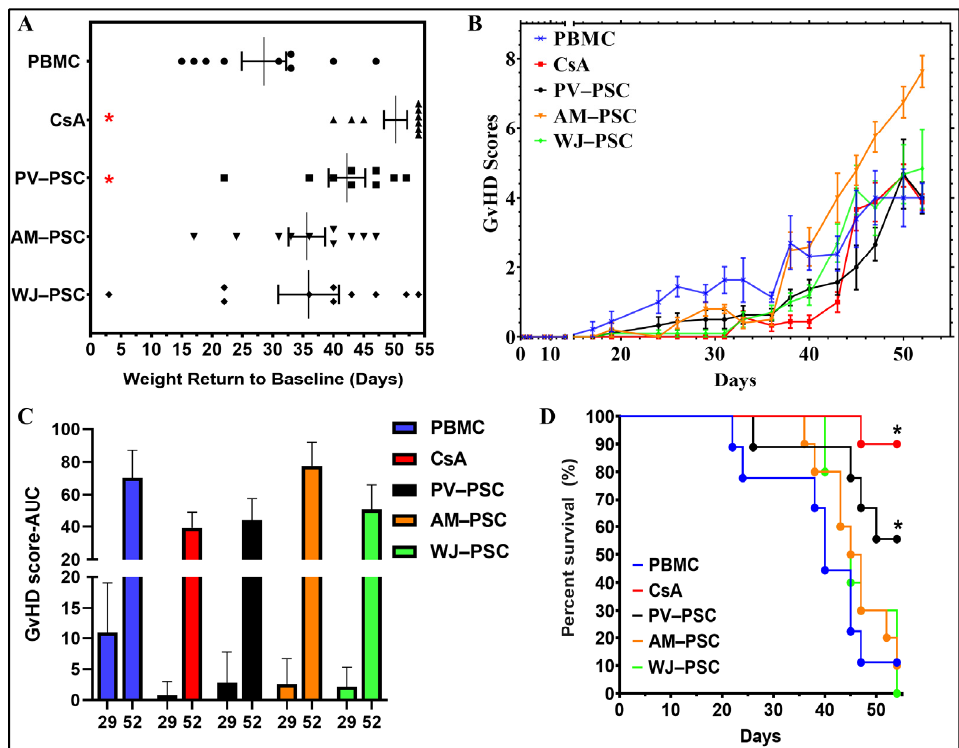
Figure 3. PV-PSC treatment significantly improved the survival rate of GvHD-affected mice as compared with other PSCs. ( A ) Time for weight return to baseline (zero change). ( B ) GvHD progression over the course of the 55-day study, as denoted by the GvHD score of the surviving animals (mean±SEM). ( C ) Area under the curve at Day 29 and 52 of the study for all treatments, indicative of cumulative GvHD progression. ( D ) Survival rate at Day 55. n = 9–10 tested in each group. Statistical significance denoted as * p < 0.05. Data presented as the average ± SEM. Abbreviations: human peripheral blood mononucleated cells (huPBMC), human perinatal stromal cells (huPSCs), amniotic perinatal stromal cells (AM-PSC), placental villi perinatal stromal cells (PV-PSC) and Wharton’s Jelly perinatal stromal cells (WJ-PSC).